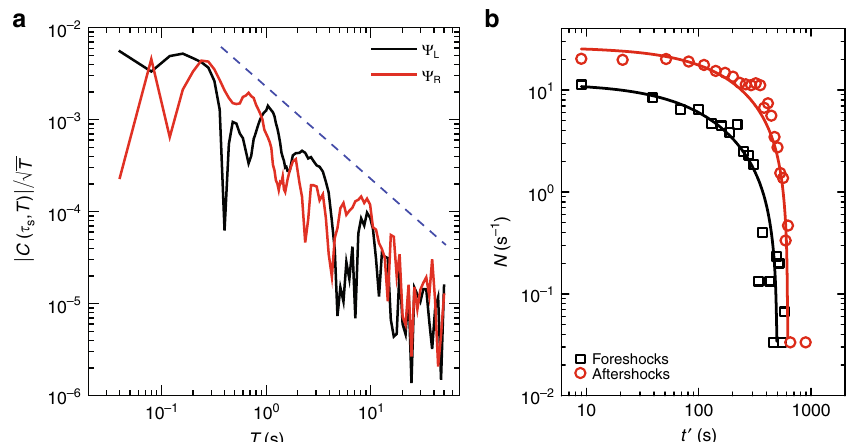
ffiffiffi p T ) before (using Ψ as the analyzing L þ A = ð c þ t 0 Þ p with p ¼ 1 0